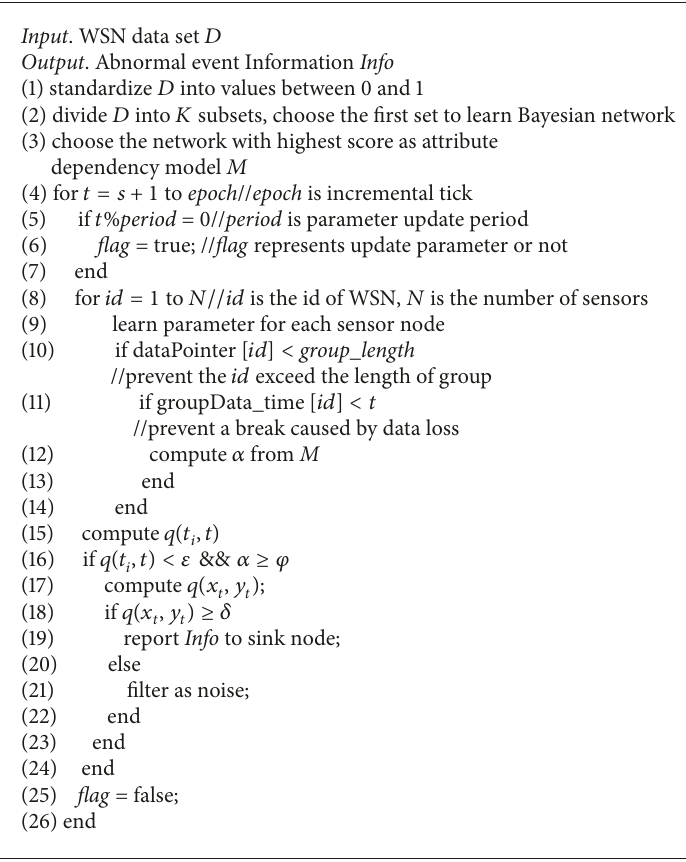
Algorithm 1: Abnormal event detection algorithm based on multiattribute correlation.